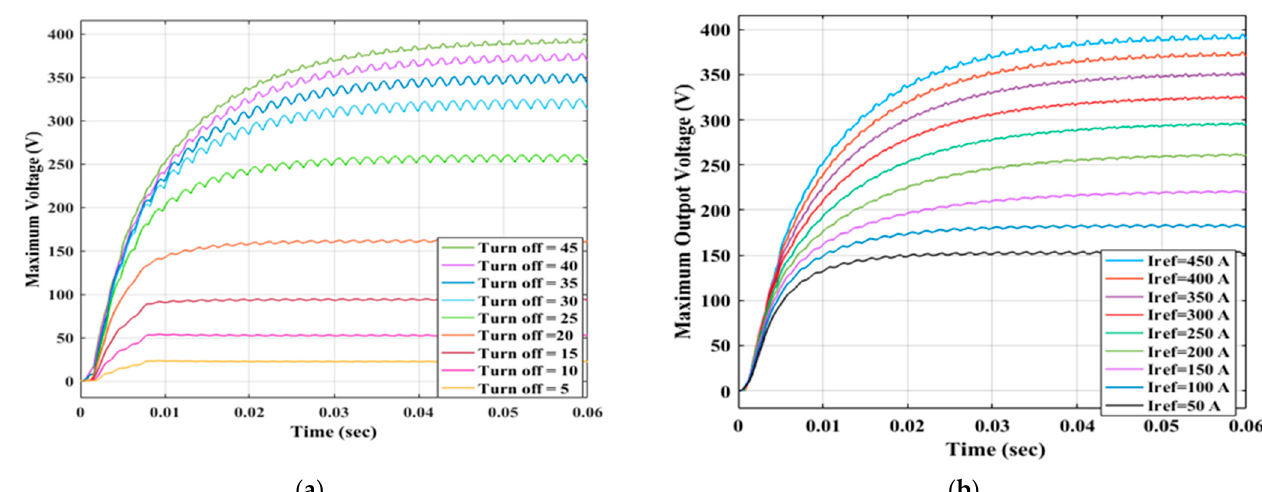
Figure 13. Maximum generated output voltage in volts at ( a ) different initial turn-off angles in deg, ( b ) different reference maximum input current.